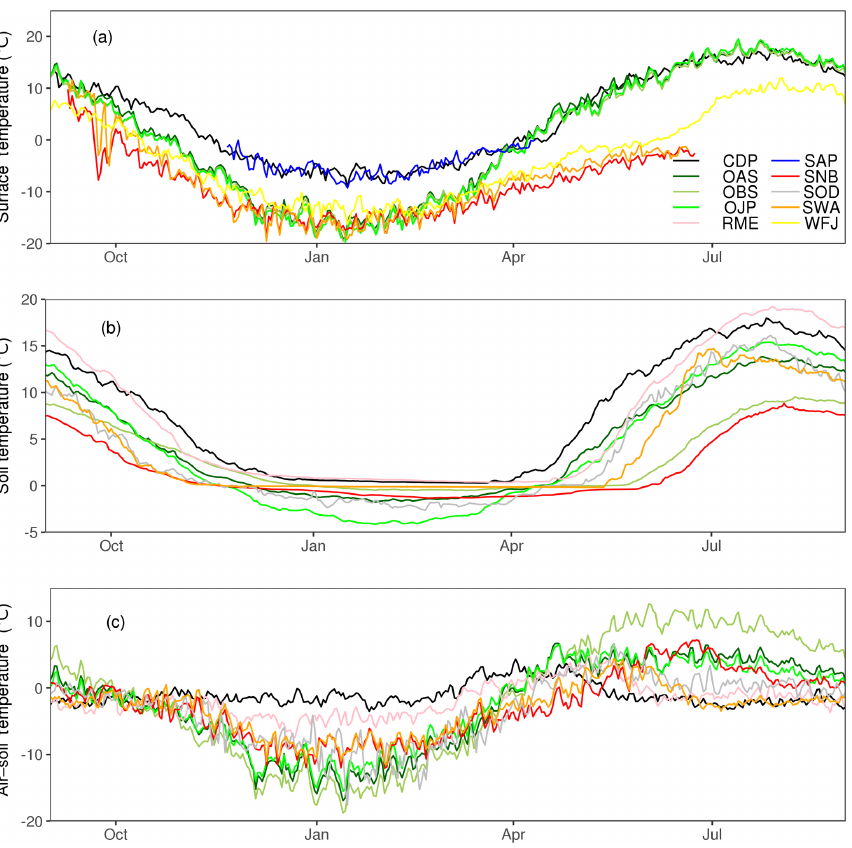
Figure 8. Daily climatological averages of surface temperature (a) , soil temperature (b) , and differences between air and soil tempera- tures (c) . Soil temperatures are shown at 30cm depth at RME and at 10cm depth at all other